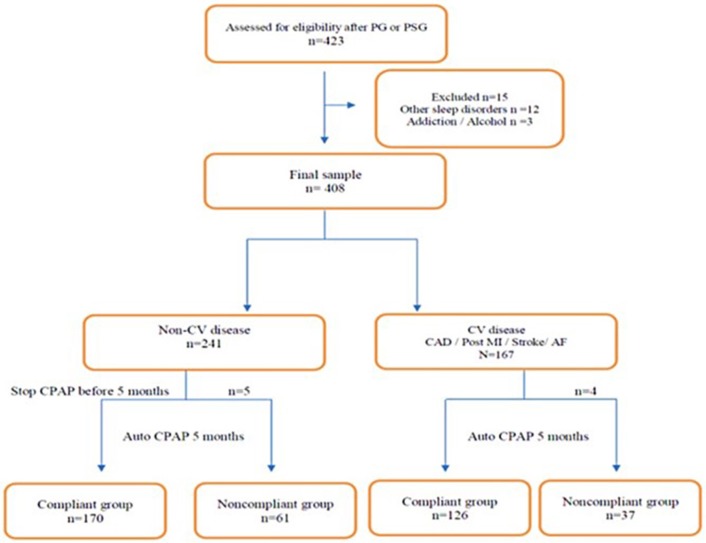
Flowchart of the population understudied according to the presence or the absence of a diagnosed cardiovascular disease at the entry in the study.